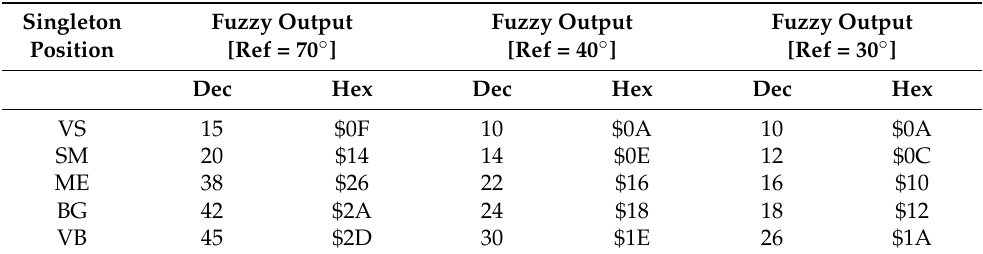
Table 3. Fuzzy output for reference angles of 70 ◦ , 40 ◦ and 30 ◦ . The singleton output MFs are Very Small (VS), Small (SM), Medium (ME), Big (BG) and Very Big (VB).